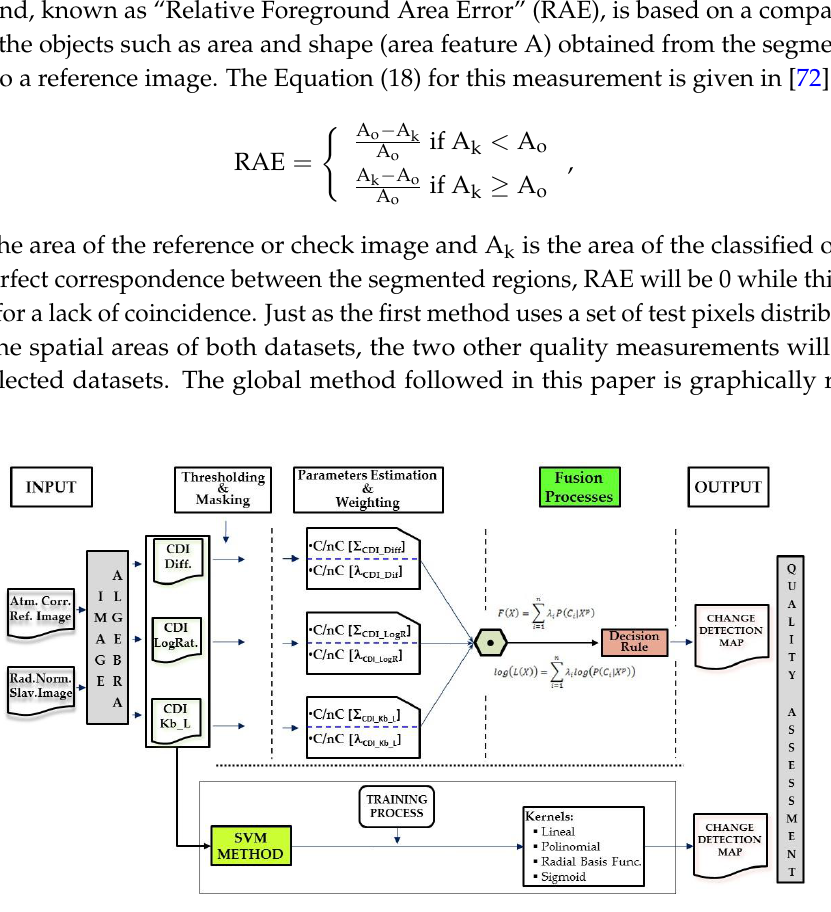
Figure 6. Detailed change detection suggested methodology.